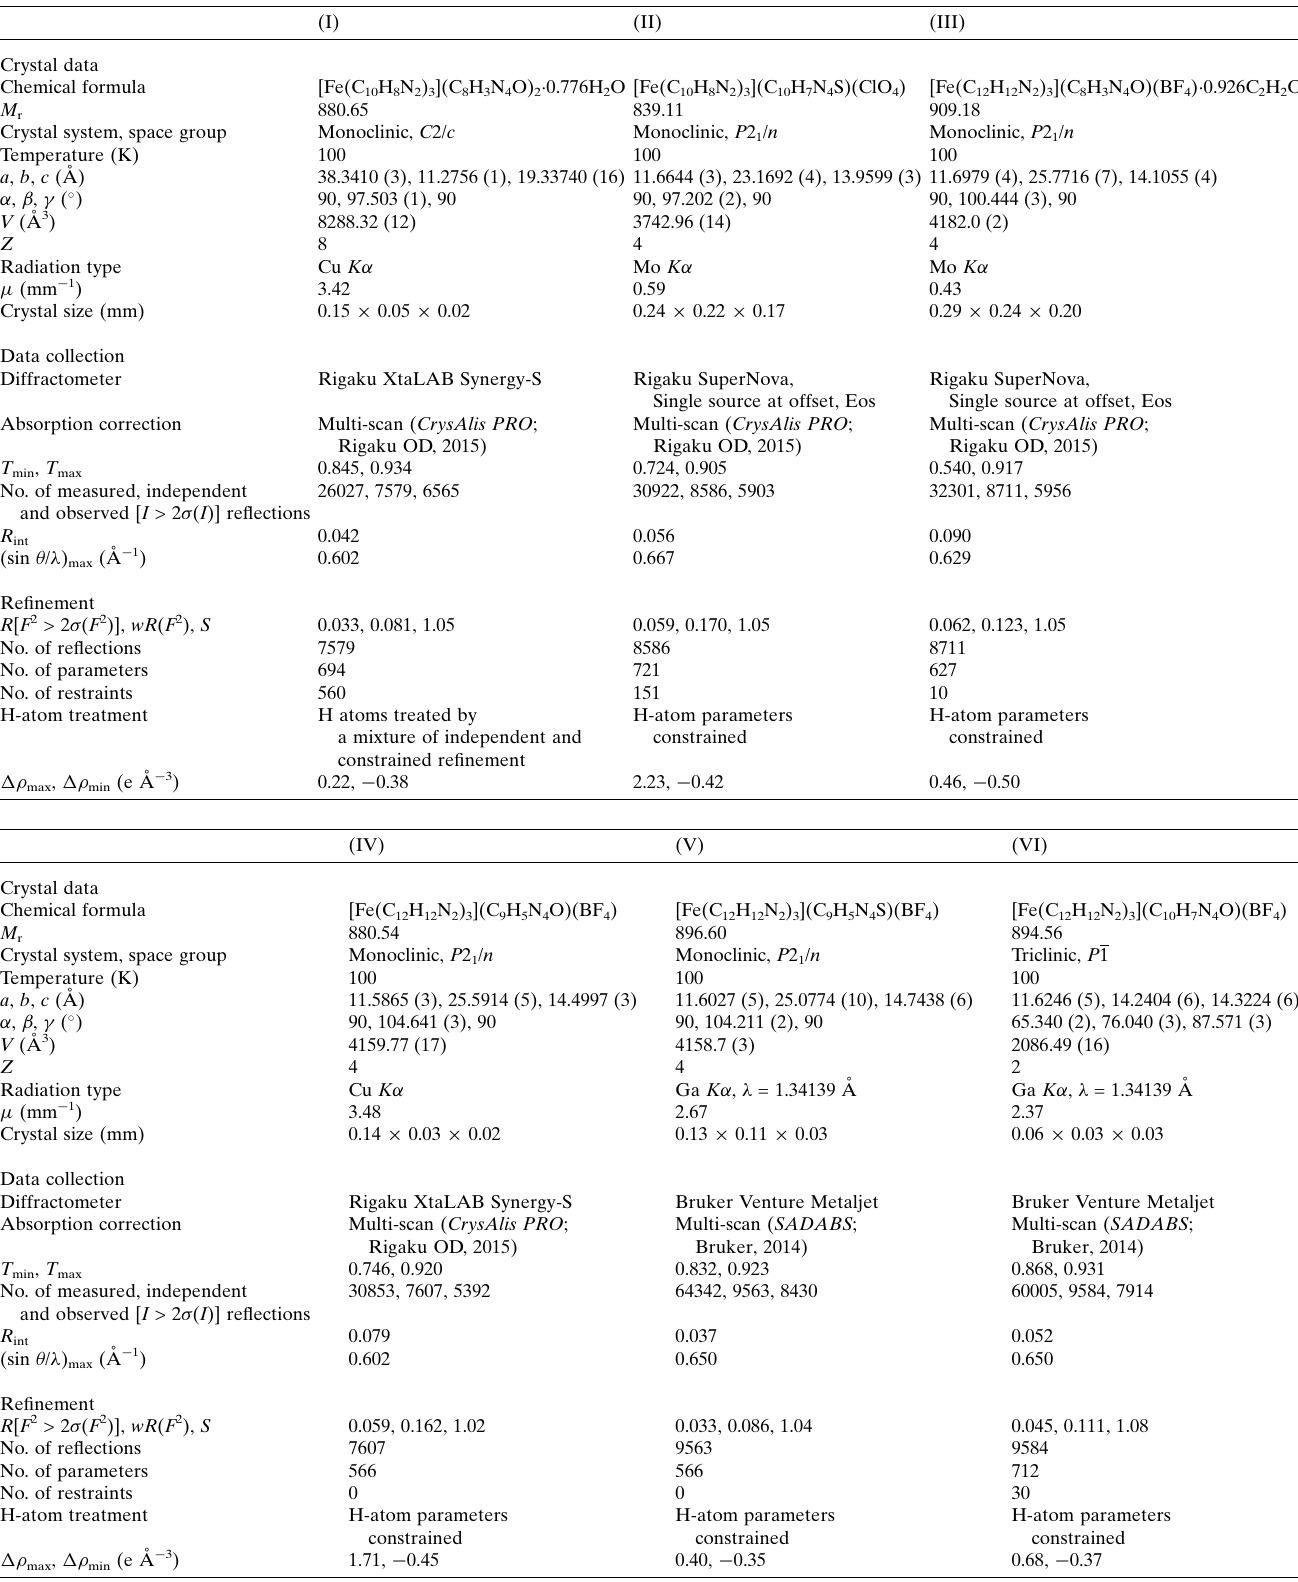
Table 3 Experimental